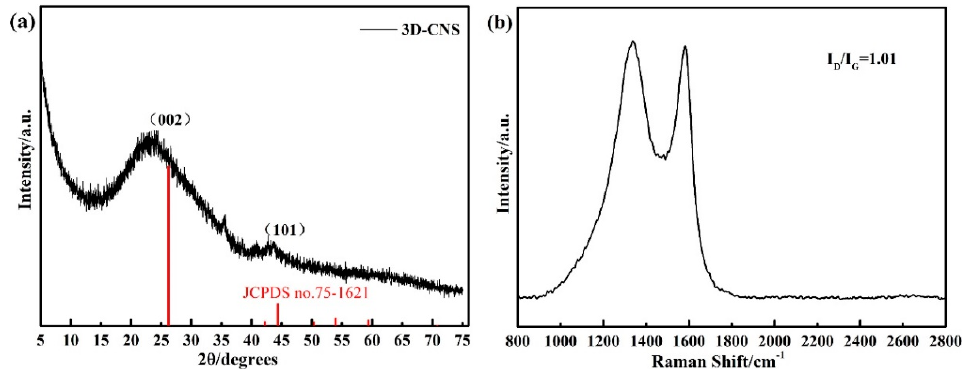
Figure 2. ( a ) XRD pattern and ( b ) Raman spectrum of 3D-CNS.